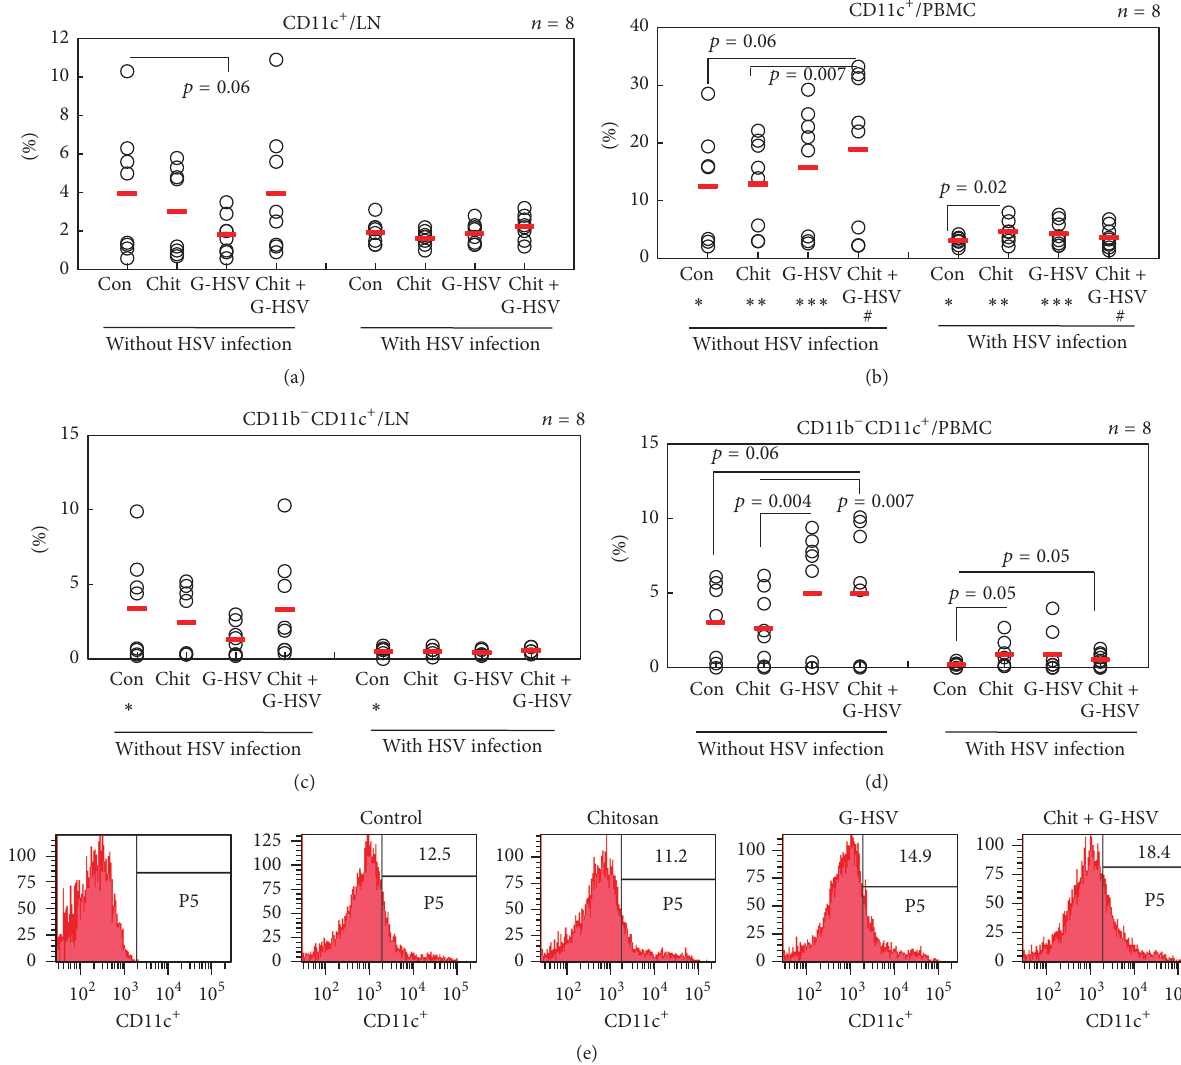
Figure 4: Chitosan controls the frequencies of CD11c + dendritic cells in HSV infection. Chitosan treatment significantly affected the frequencies of CD11c + dendritic cells in HSV infection group. (e) Representative histogram of the frequency of CD11c + cells in PBMC with HSV infection. The numbers of mice used were 8 in each group. In (b) ∗ 𝑝 = 0.01 , ∗∗ 𝑝 = 0.01 , ∗∗∗ 𝑝 = 0.005 , and # 𝑝 = 0.002 . In (c) ∗ 𝑝 = 0.04